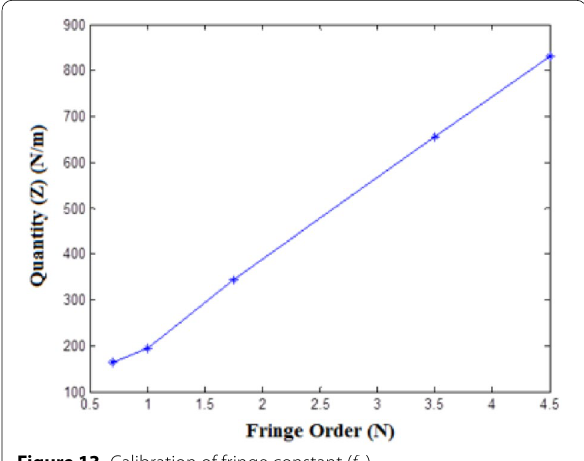
Figure 13 Calibration of fringe constant ( f σ